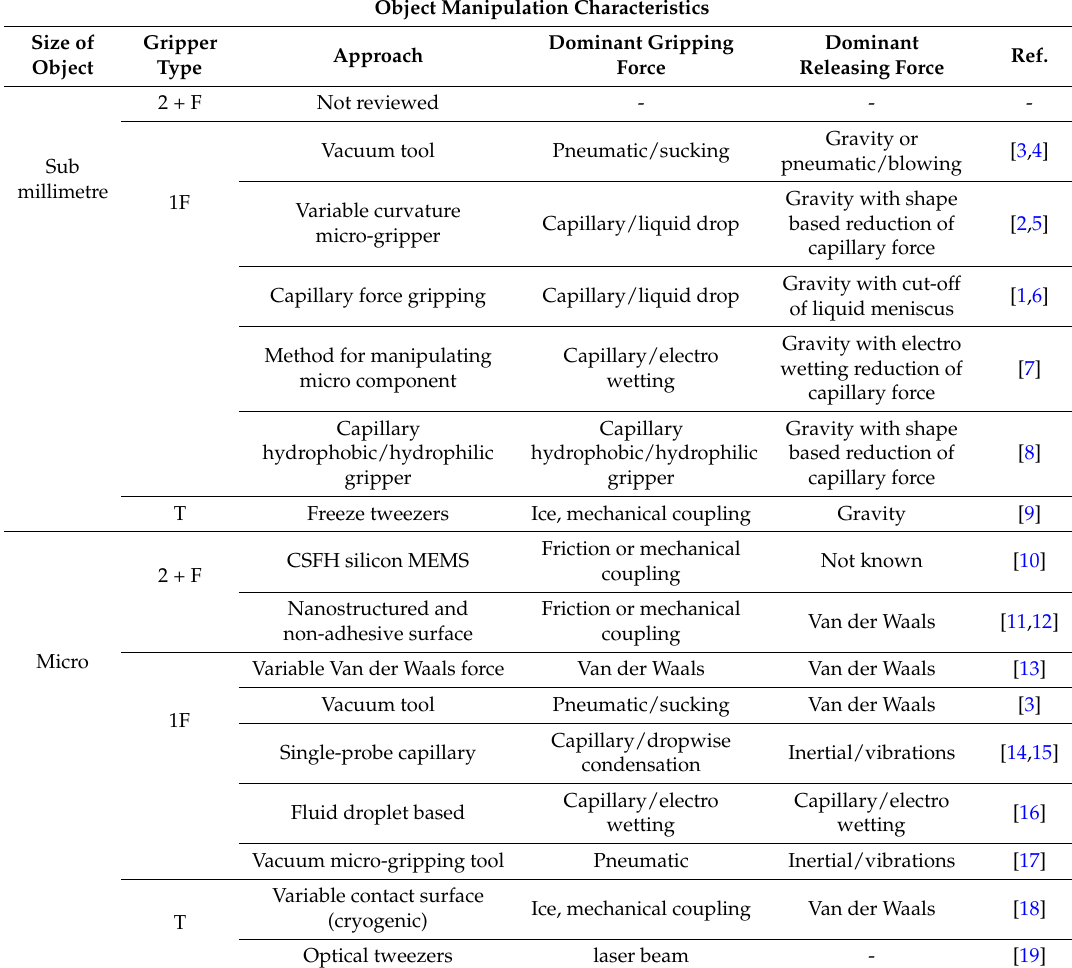
Table 1. Overview of micro-assembly